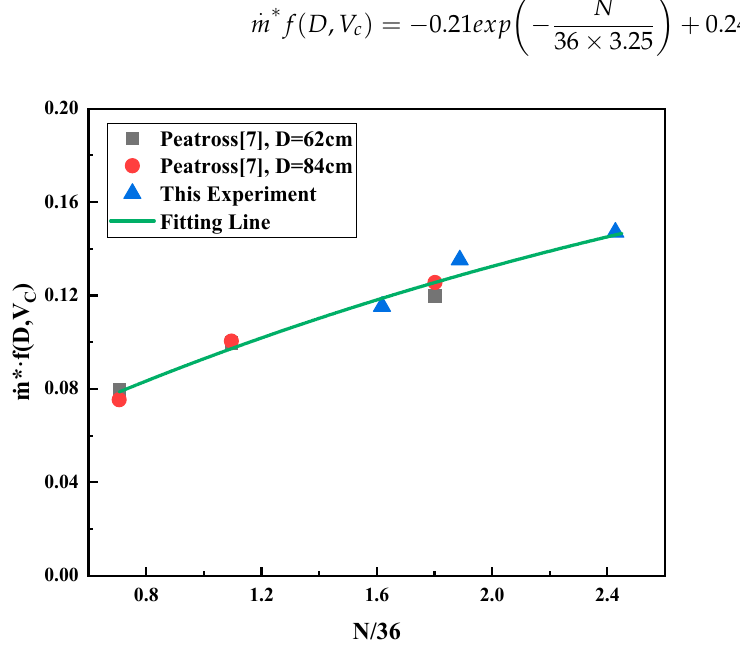
Figure 5. Relationship between dimensionless mass loss rate and dimensionless air volume.